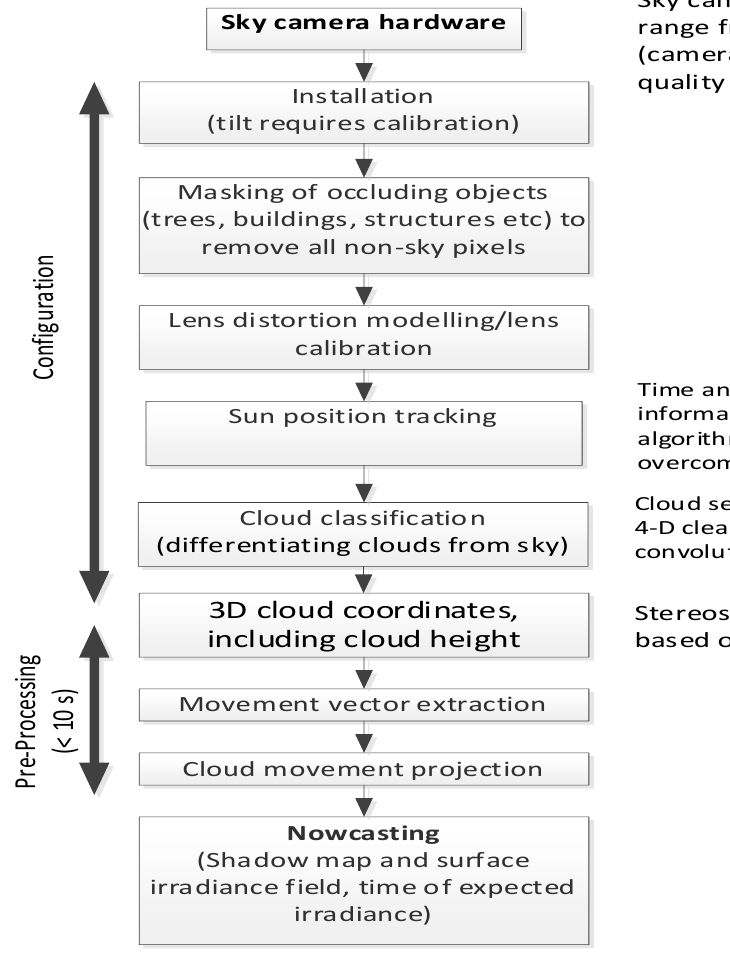
Figure 1. A flow diagram of nowcasting using ASIs.